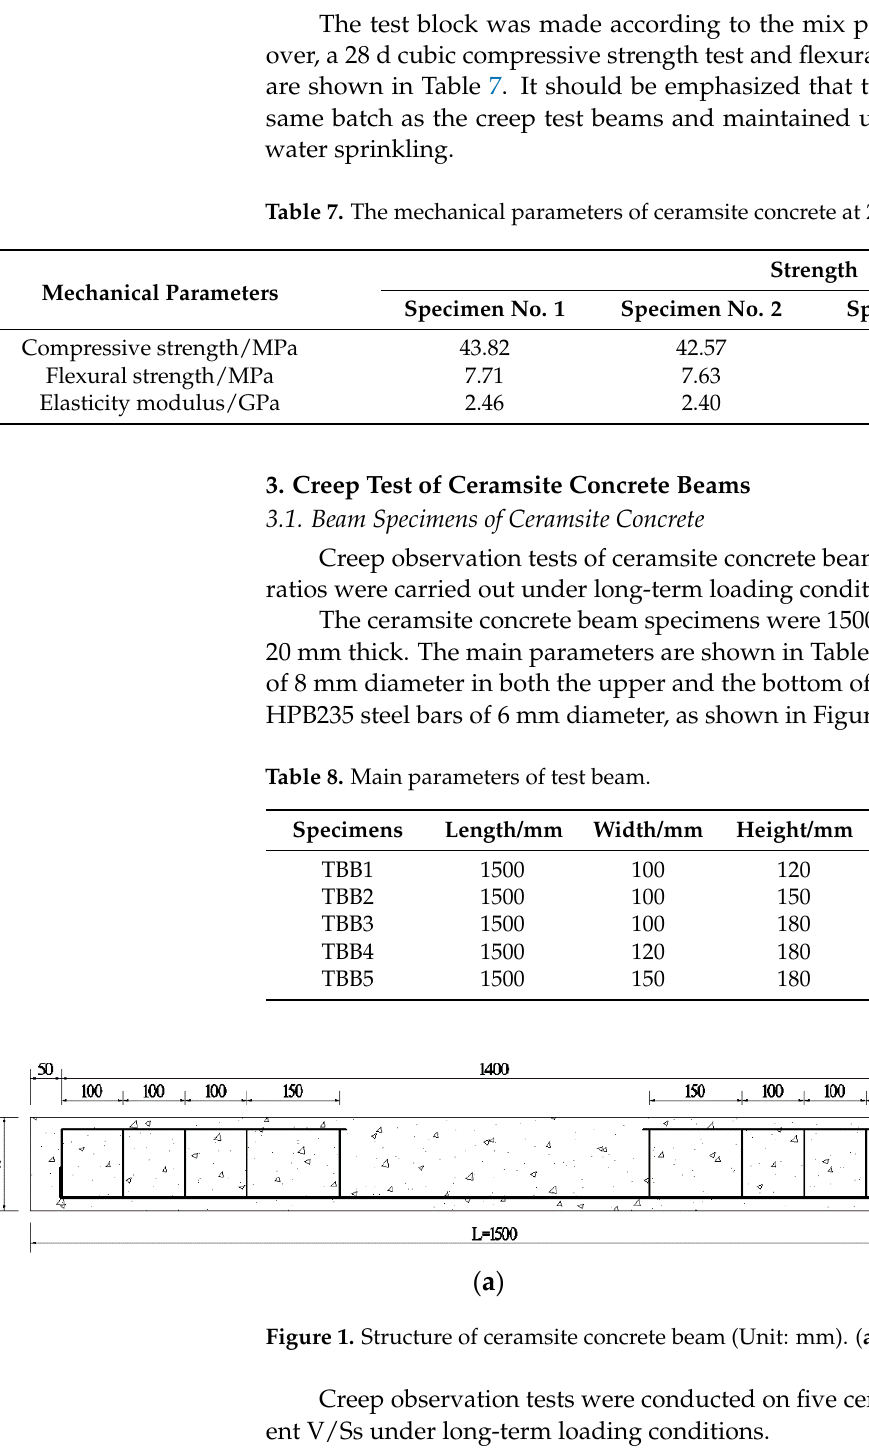
Table 7. The mechanical parameters of ceramsite concrete at 28 d.